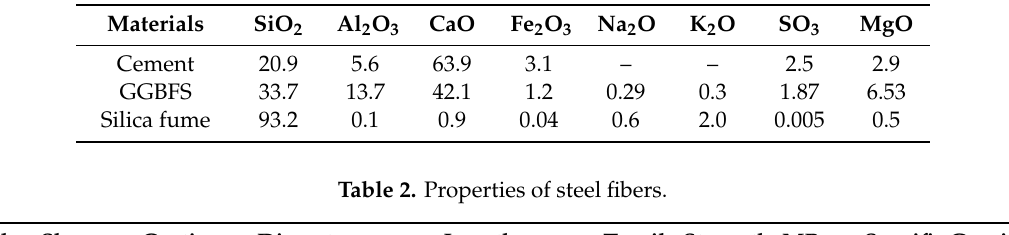
Table 1. Chemical compositions of cement, GGBFS, silica fume (%).